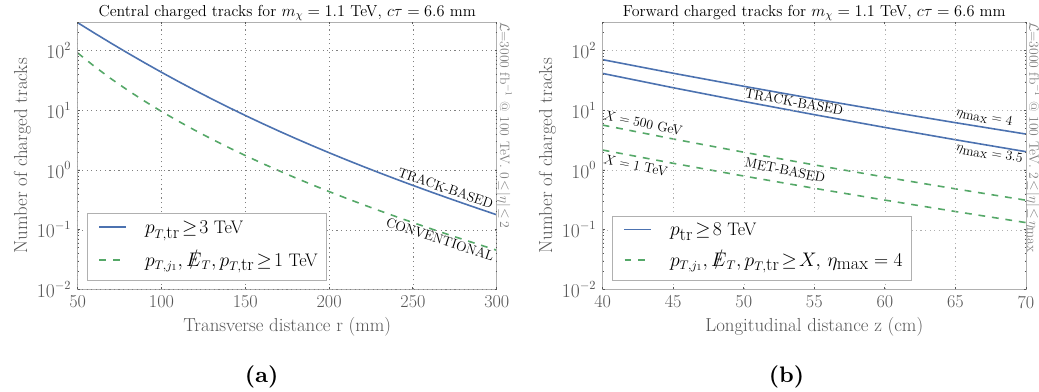
Figure 6. Number of charged tracks in track-based (TB) analysis for reference values m 1 : 1 TeV, c(cid:28) = 6 : 6 mm, in (a) central region as a function of transverse distance r from the beamline, with the number of tracks in the conventional analysis shown for comparison, and (b) forward region as a function of the longitudinal distance z from the interaction point, for two di(cid:11)erent values of the pseudorapidity extent. We also show the number of charged tracks available in the forward direction using standard jet p T and MET